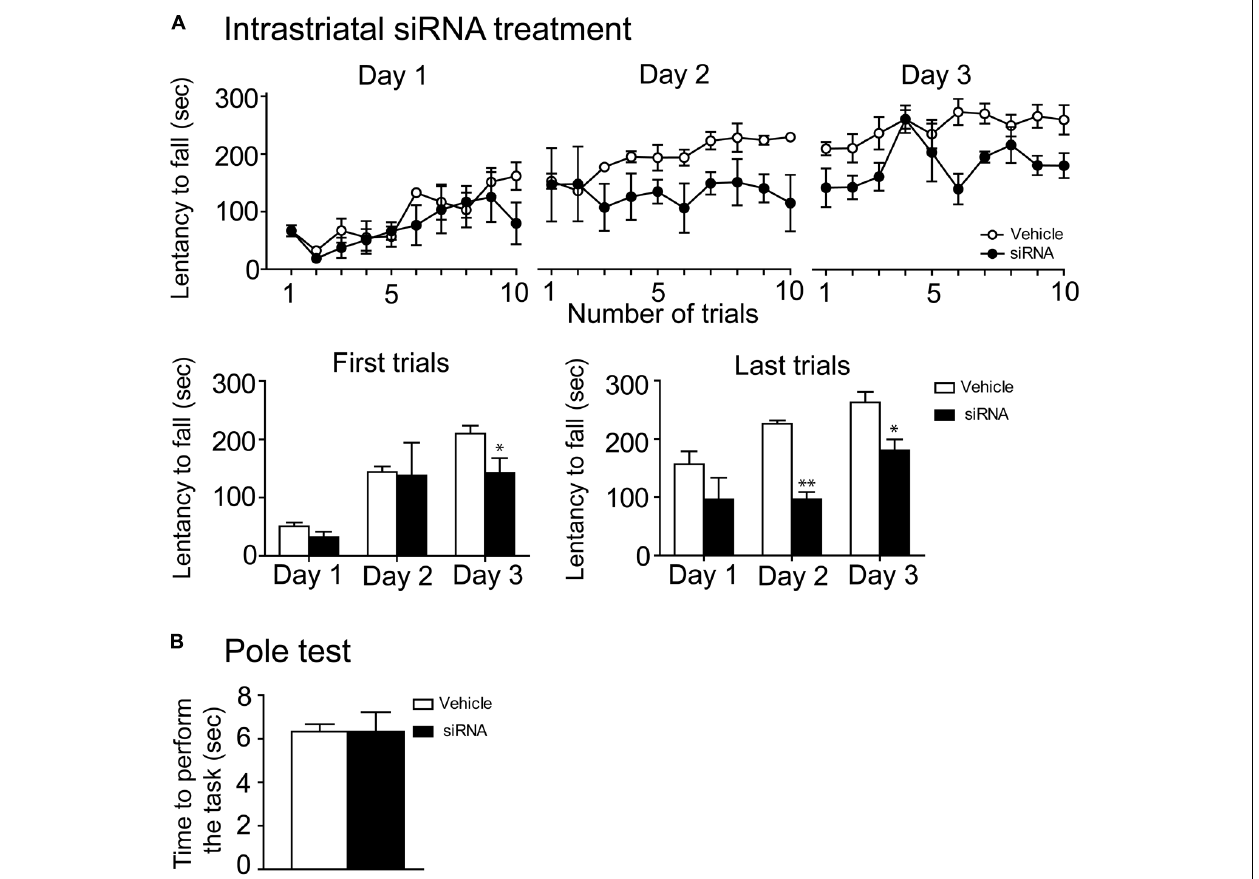
latency to fall expressed in seconds ± S.E.M, n = 3–4 vehicle-treated and siRNA-treated mice. ** P < 0.01 and * P < 0.05 vs. respective vehicle-treated group. (B) Motor abilities of mTOR siRNA-treated mice were also assessed by the pole test and compared to their respective controls. Data represent the time required to perform the task in second ± S.E.M, n = 3–4